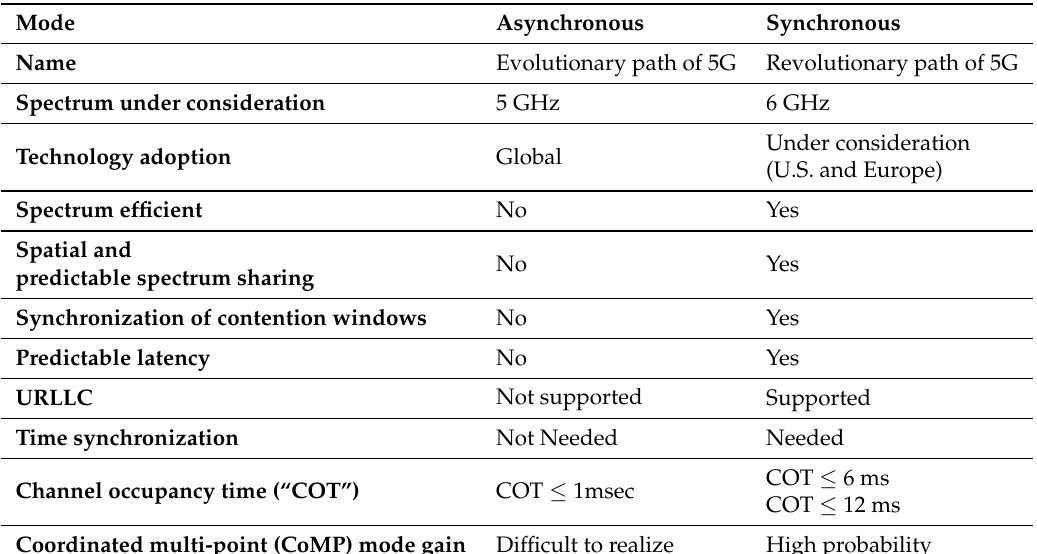
Table 4. Comparison of the asynchronous and synchronous modes of spectrum sharing. URLLC, ultra-reliable low-latency communications.